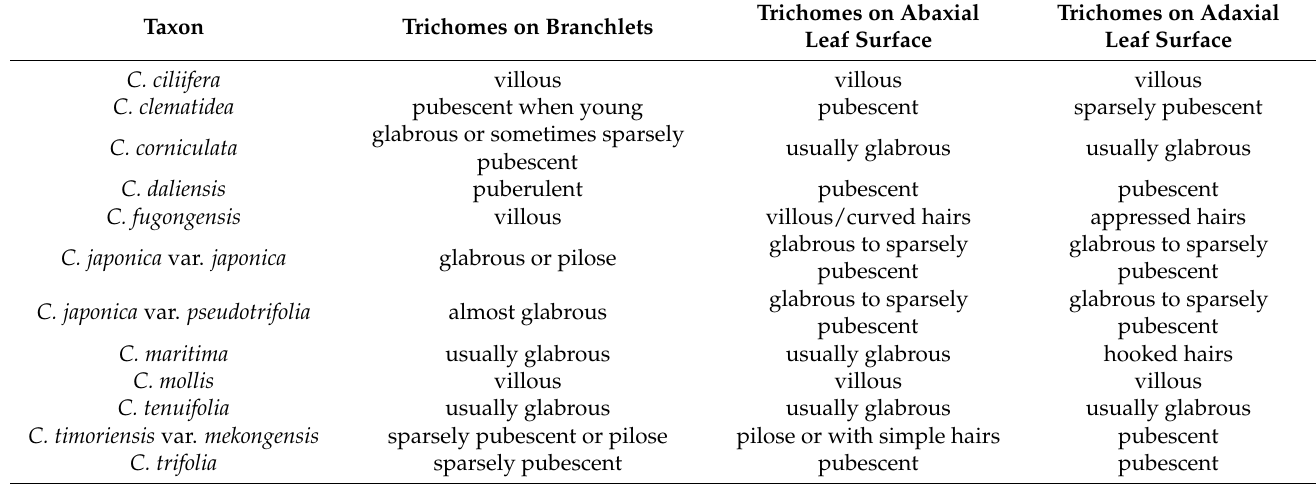
Table 2. Morphology of trichomes on branchlets and